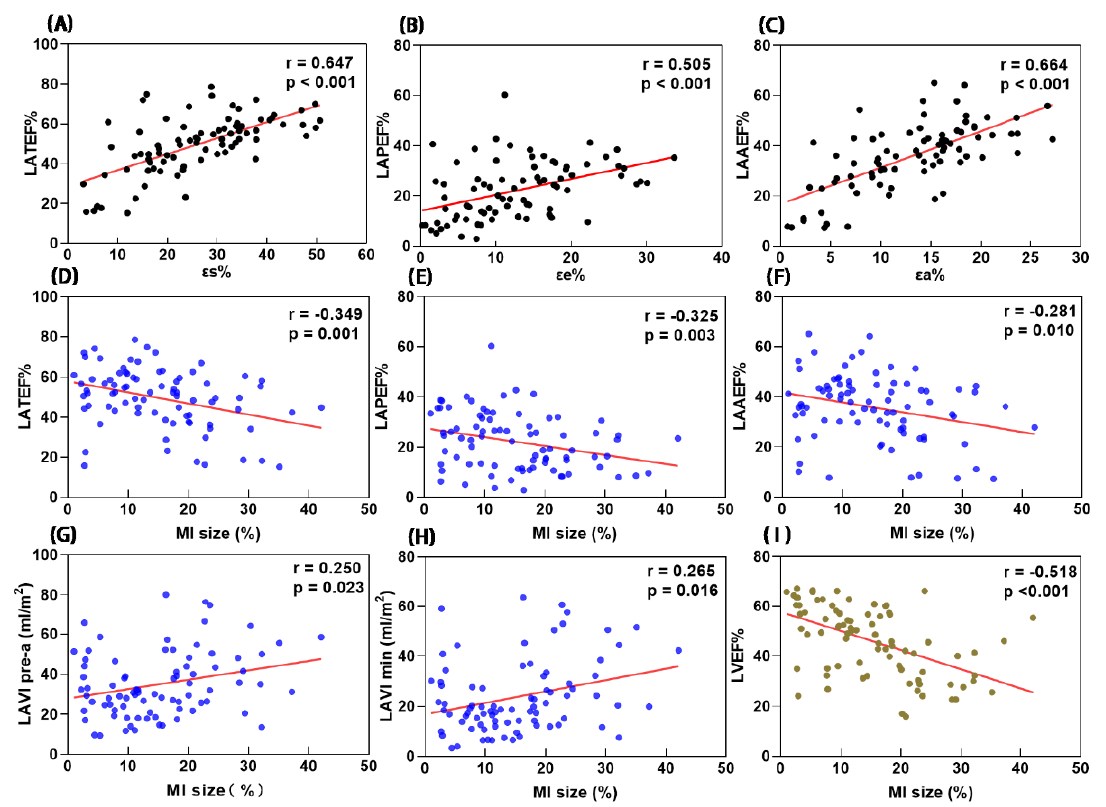
Figure 4. Scatter plots showing correlations of LATEF and ε s ( A ), LAPEF and ε e ( B ), LAAEF and ε a ( C ), LA function and MI size ( D – F ), LA volume and MI size ( G , H ), LVEF and MI size ( I ). LA = left atrial, LV = left ventricular, EF = emptying fraction, ε s = total strain, ε e = passive strain, ε a = active strain. Table 5. Correlations of CMR-FT derived parameters with MI size in all patients with previous MI.